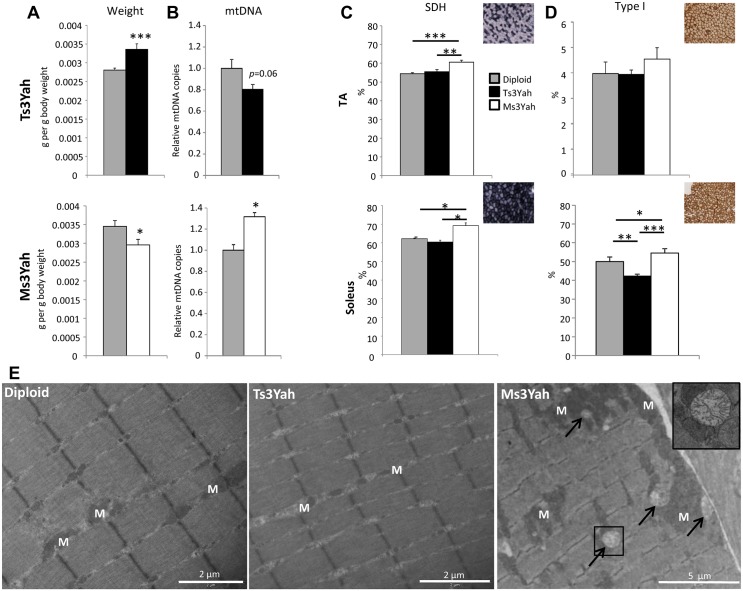
Histological analyses of skeletal muscles.(A) Mass of gastrocnemius muscles reported to body weight of the mice (n = 10–15 per group). (B) Quantification of the mitochondrial copy number in the gastrocnemius muscles of Ts3Yah and Ms3Yah mice relative to their diploid controls. The levels of mtDNA were normalised to levels of nucleus-encoded DNA (n = 5 per group). (C) Transverse sections of TA and soleus muscle were stained for SDH activity and SDH+ fibres counted in the entire sections. Results are given as percentages of stained fibres (n = 5–7 per group). (D) Changes in the proportion of type I slow-twitch fibres in TA and soleus of Ts3Yah and Ms3Yah mice using MyHC immunohistological staining (n = 5–7 per group). Data are presented as mean ± sem. Student’s t-test (A and B) and ANOVA with all pairwise multiple comparison procedures (Holm-Sidak method) (C and D), ~p<0.1, *p<0.05, **p<0.01, ***p<0.001. (E) Transmission electron microscope (TEM) analysis of TA muscles. The arrows are pointing at degenerative mitochondria. The cropped image is shown with 2.5x magnification of the original image. M: mitochondrion. Scale bars are 2 μm for the two first panels and 6 μm for the last.